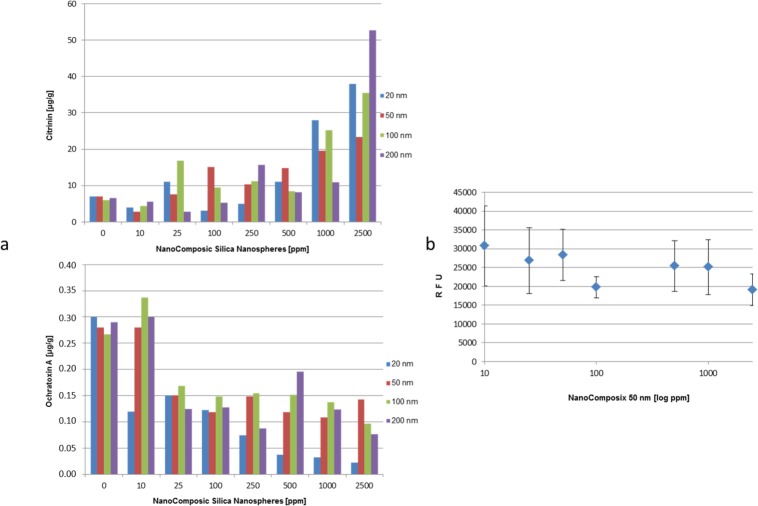
Mycotoxin biosynthesis and intracellular ROS level of P. verrucosum supplemented by NanoComposix SiO2 nanospheres.ROS and mycotoxins have been analyzed at the same time points. (a) Biosynthesis of citrinin and ochratoxin A by P. verrucosum growing 7 days at 25°C under shaking at 230 rpm in MEA-liquid medium supplemented by different amounts (0–2,500 ppm) of NanoComposix SiO2 nanospheres exhibiting sizes of 20 nm, 50 nm, 100 nm and 200 nm. (b) Determination of intracellular ROS in P. verrucosum at the end of 7 days of growth at 25°C, under shaking at 230 rpm, in MEA-liquid medium, supplemented by different amounts (0–2,500 ppm) of NanoComposix 50 nm sized SiO2 nanospheres. Logarithmic calculation. Data in S3 data set.